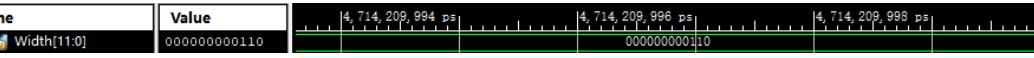
Figure 14. Crack maximum pixel pitch simulation results.